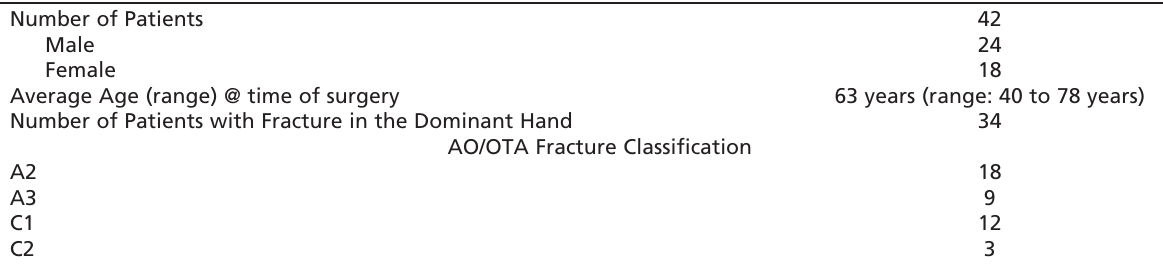
Patient demographics and fracture classification Table I: